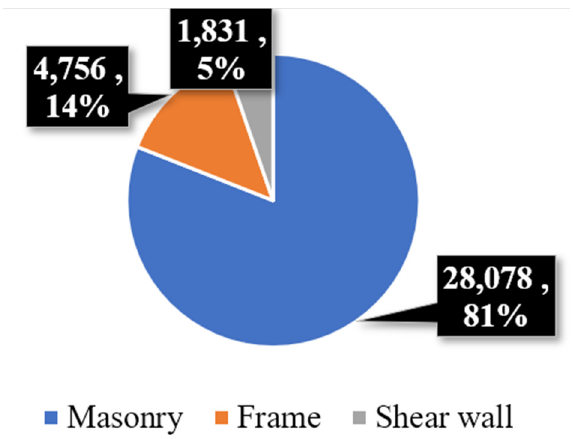
Figure 28. Ratios of structural type in Tongzhou downtown.